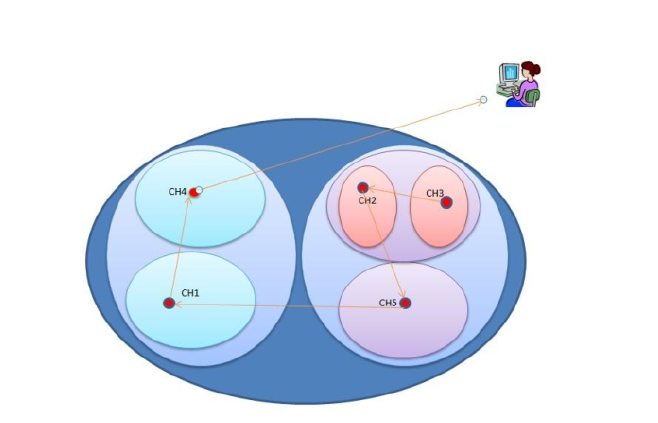
Figure 4. An overview of the Cluster Splitting Process (CSP)